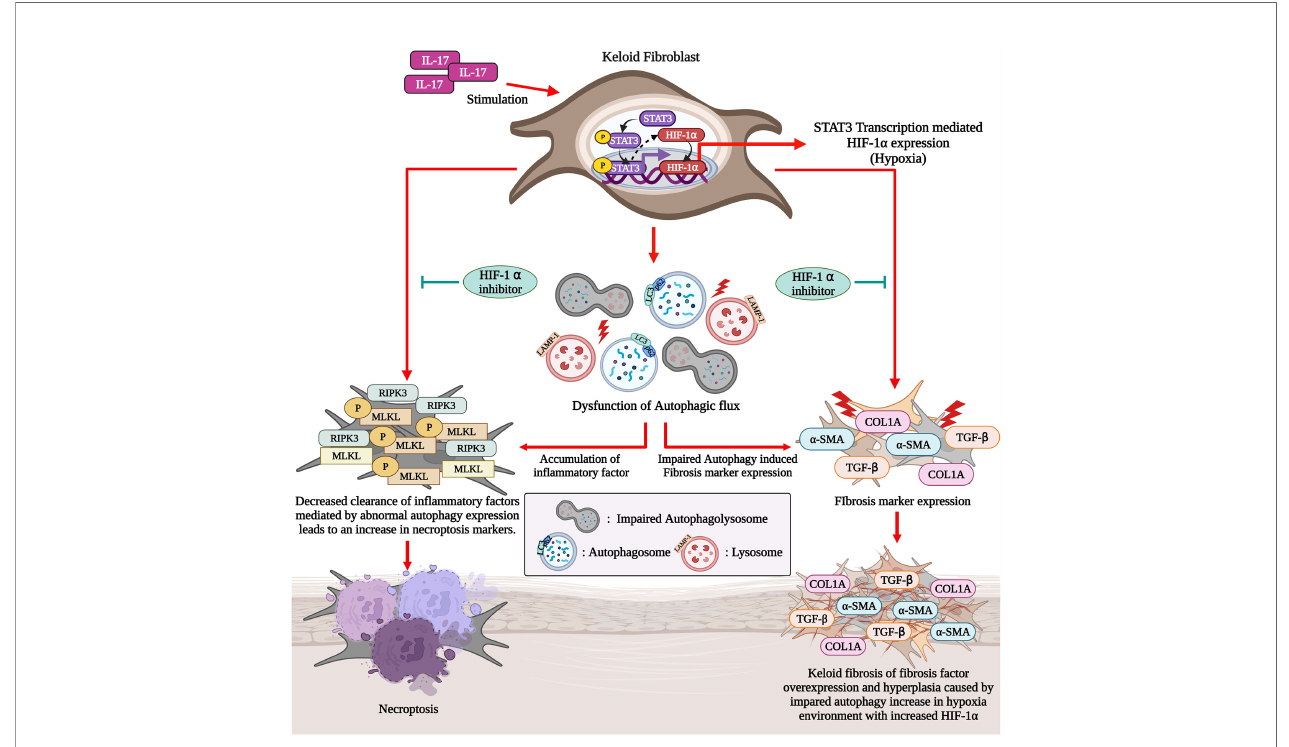
FIGURE 6 | IL-17-activated STAT3 and HIF-1 a signaling induces defective autophagy and necroptosis in KF (Graphic Created with